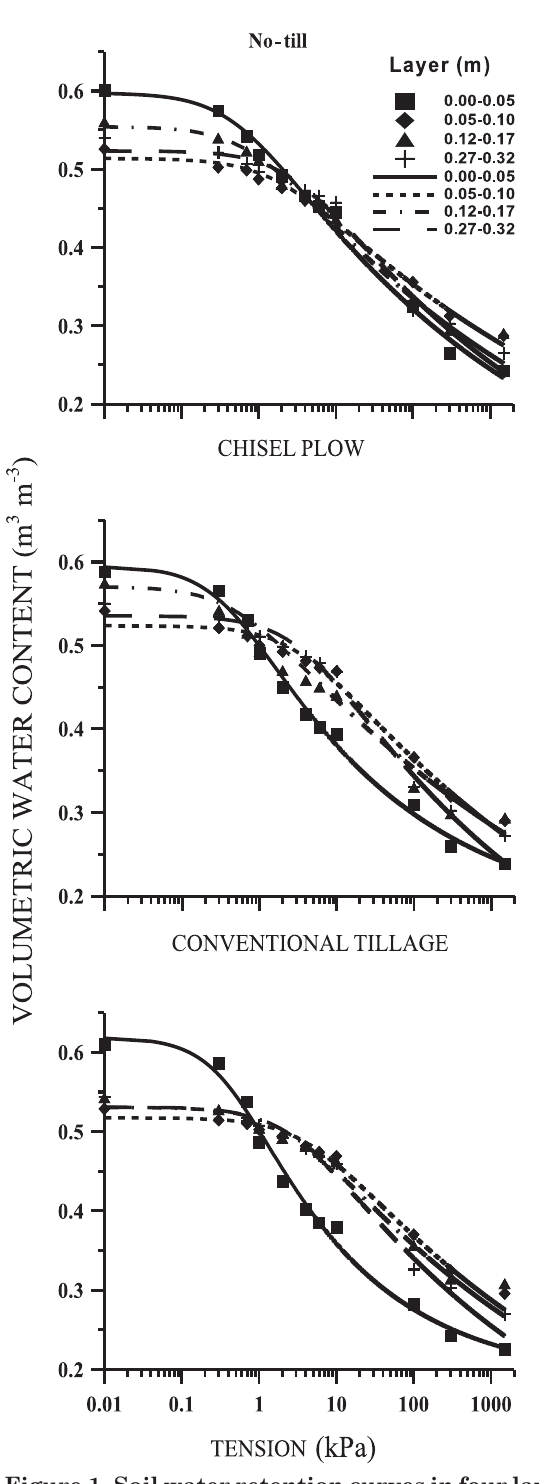
Figure 1. Soil water retention curves in four layers, after nine years of no-till, chisel plow and conventional tillage systems (averaged across nutrient